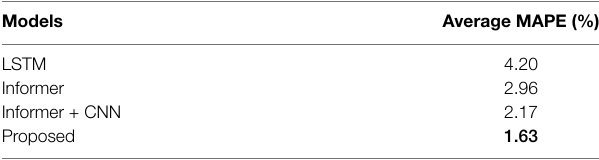
TABLE 1 | Forecast results for the testing set of the GEFCom2014 data set.